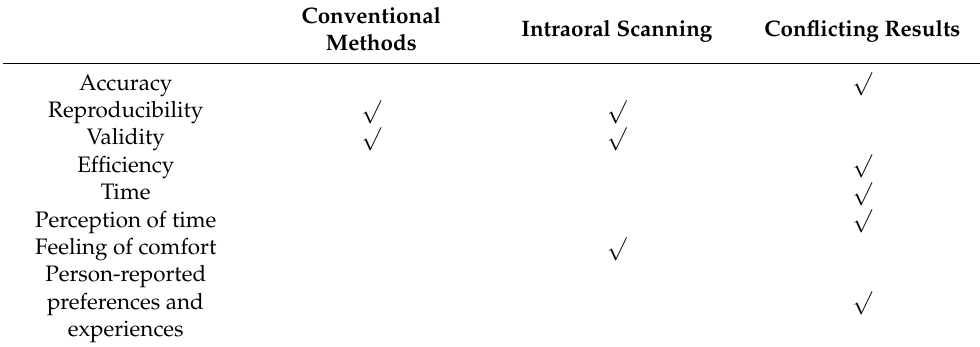
Table 1. Clinical aspects of conventional methods and intraoral scanning.